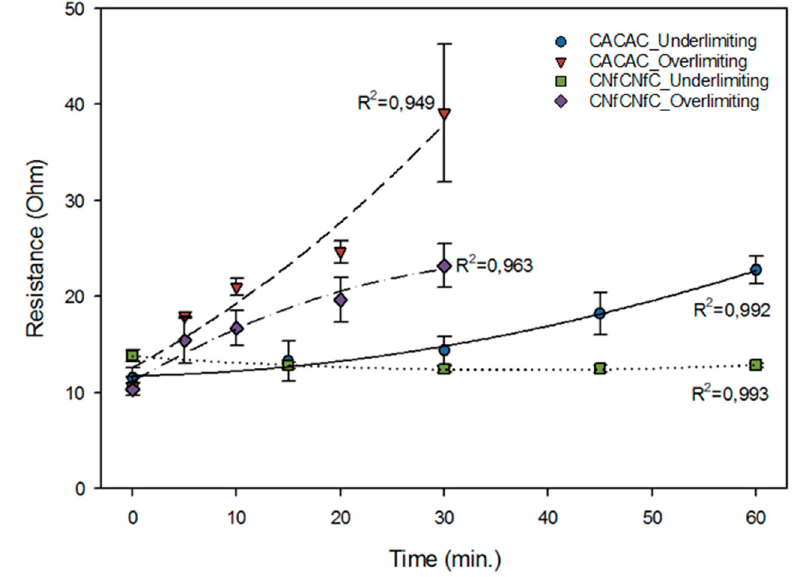
Figure 9. Overall system resistance of the electrodialysis cell.